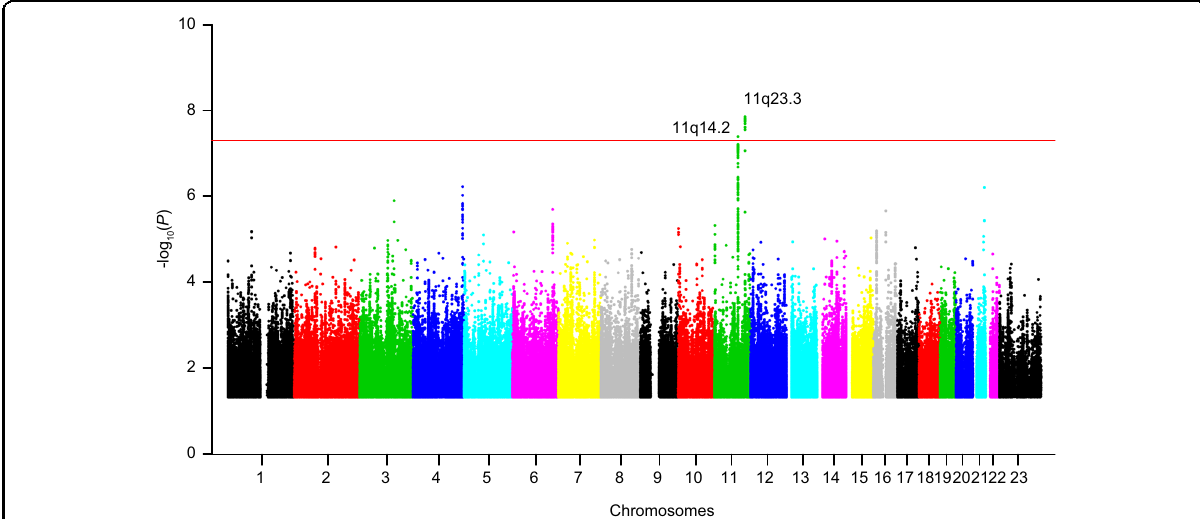
Fig. 2 Manhattan plot of the meta-analyses association statistics highlighting two loci signi fi cantly associated with COVID-19 severity. The Manhattan plot showed the genome-wide association statistics from the main meta-analyses (adjusting for age, gender, comorbidities, and the top fi ve principal components) of the Huoshenshan and Union cohorts. The red dashed line indicates the genome-wide signi fi cance threshold of P = 5 × 10 − 8 . Two loci (11q14.2 and 11q23.3) reached this threshold, and were highlighted. The x -axis represents the genomic position (human genome assembly hg19), and the y -axis shows the − log 10 ( P